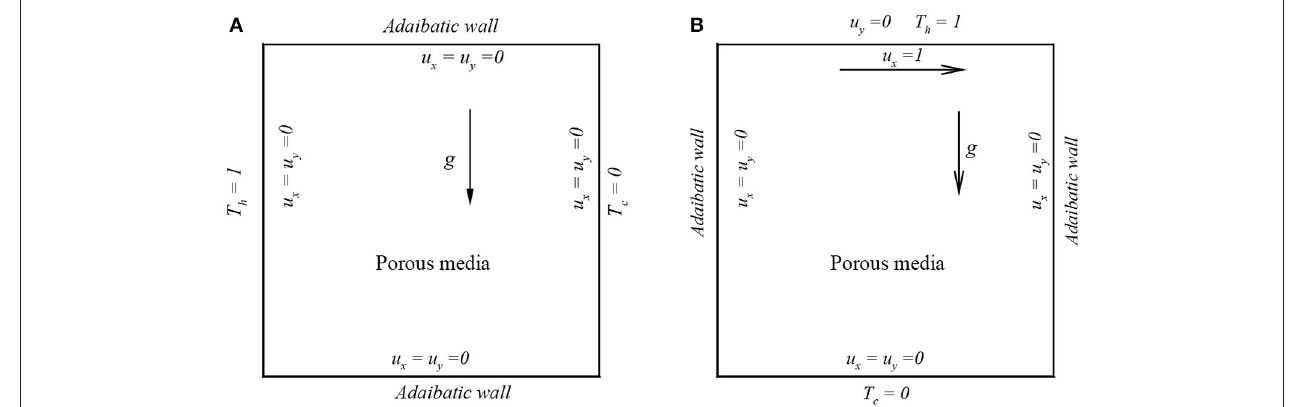
FIGURE 2 | Schematic model for convective flows in square cavity: (A) natural convection and (B) mixed